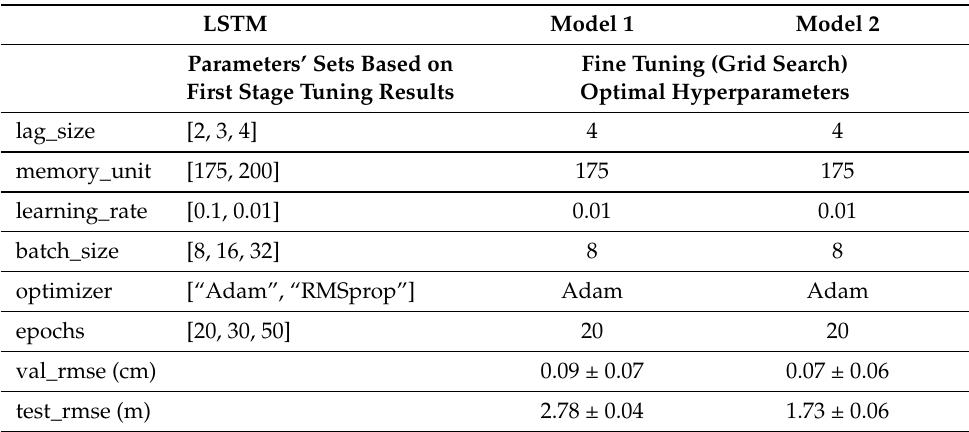
Table 5. LSTM Model 1 and Model 2 second stage Grid Search results. LSTM Model 1 Model